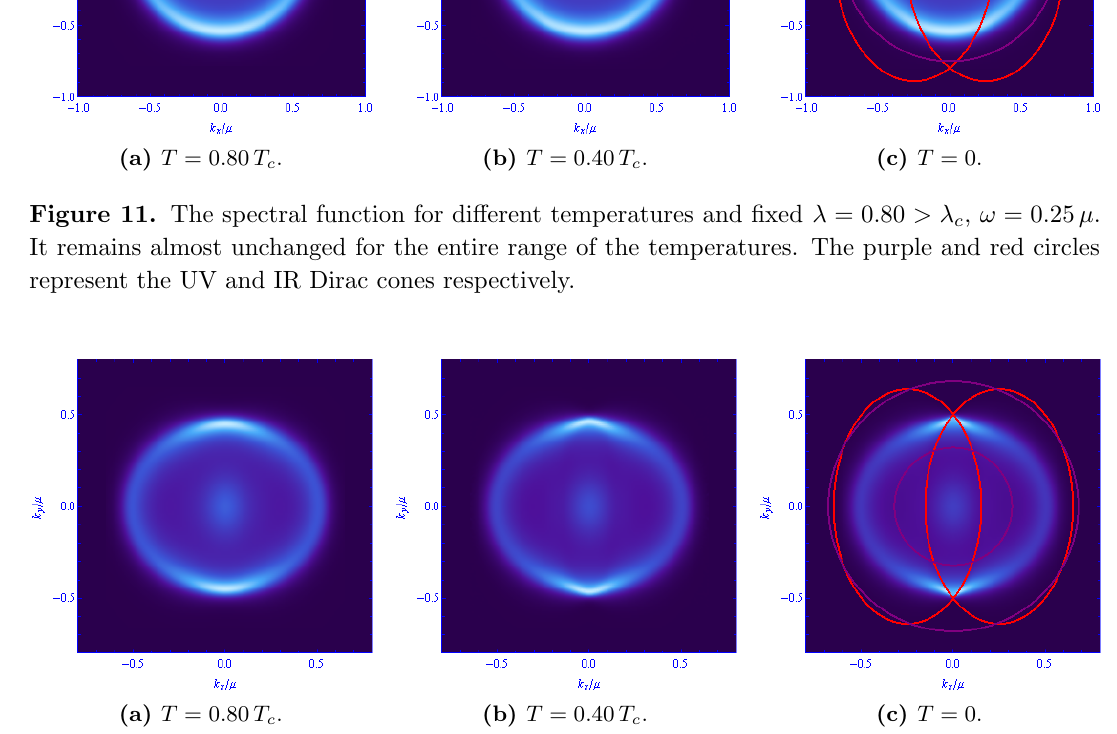
Figure 12. The spectral function for di(cid:11)erent temperatures and (cid:12)xed (cid:21) = 0 : 80 > (cid:21) c , ! = 0 : 18 (cid:22) . It remains almost unchanged for the entire range of the temperatures. The purple and red circles represent the UV and IR Dirac cones